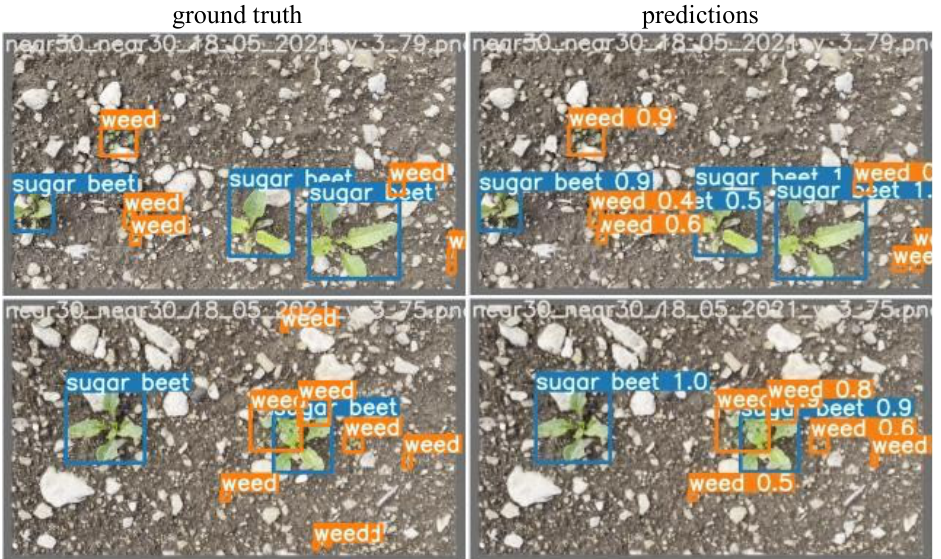
Figure 6. Some examples of YOLOv7 detections on LB test images. The left column contains some test images of the LB dataset with ground truth bounding boxes labeled as “weed” or “sugar beet”. In the right column, the same images are shown but with the bounding boxes predicted by the YOLOv7